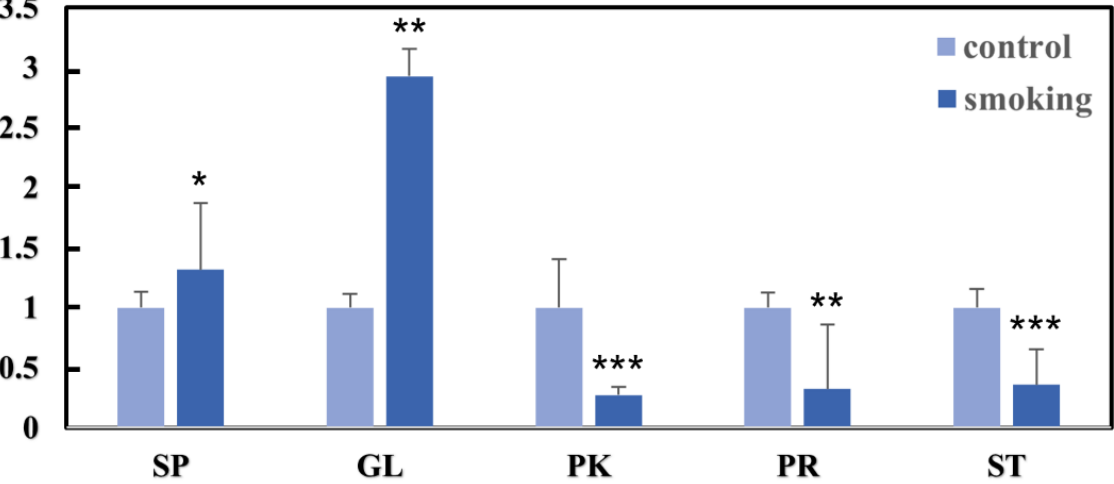
Figure 3. Comparison of differences in lipids in the smoking and control groups. These units are ‘relative to the value for non-smokers, which is set at a value of 1’. *** p < 0.001; ** p < 0.01; * p < 0.05.